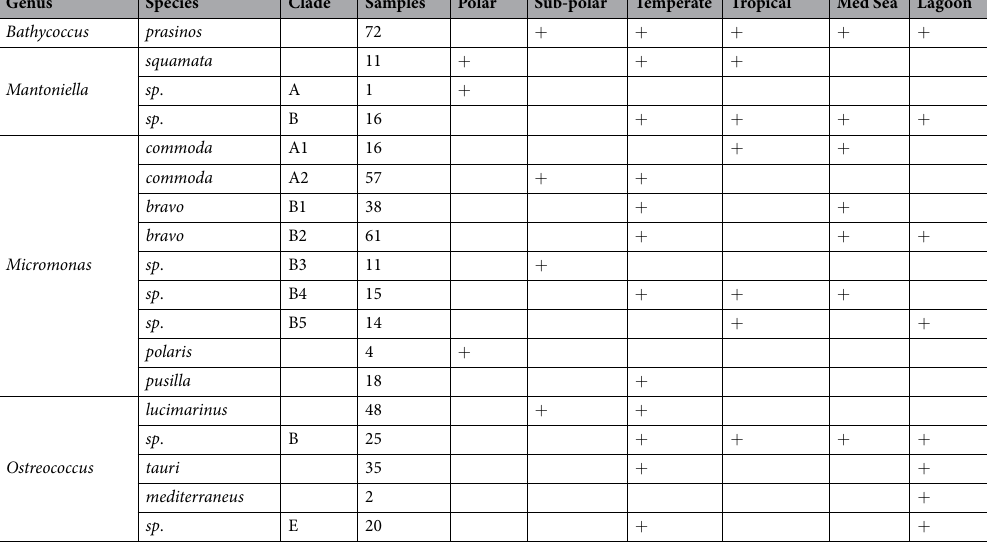
Table 3. Summary of the coastal distribution of Mamiellophyceae species and clades. The column “Samples” indicates the number of samples where the species/clade represented more than 1% of Mamiellophyceae reads in the LGC dataset. For Mantoniella clade A was only oberved in the LW dataset. Crosses correspond to the habitat where a given species/clade is